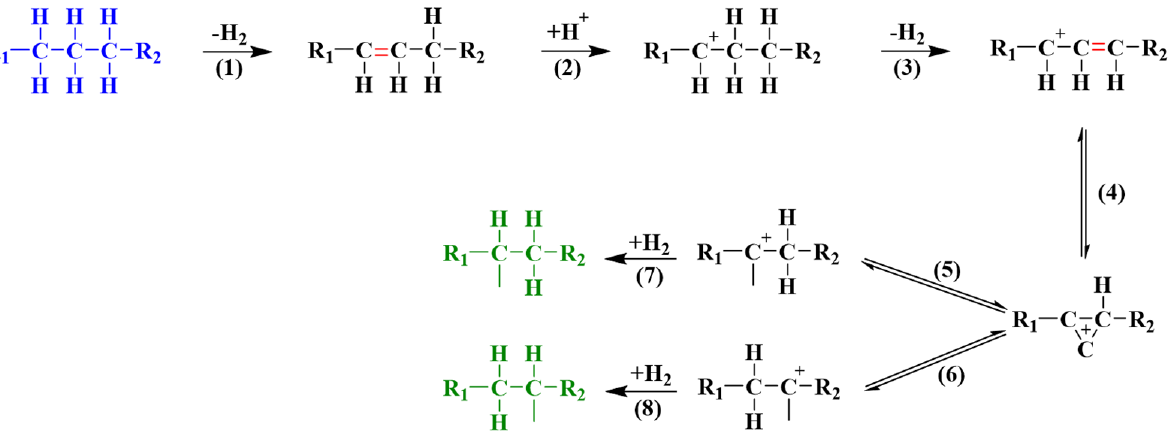
Figure 4. Hydroisomerization of normal paraffin. The (de)hydrogenation process in steps (1), (3), (7), and (8) occur at the metallic sites, while the carbenium rearrangement process in steps (2), (4), (5), and (6) occur at the acidic sites.